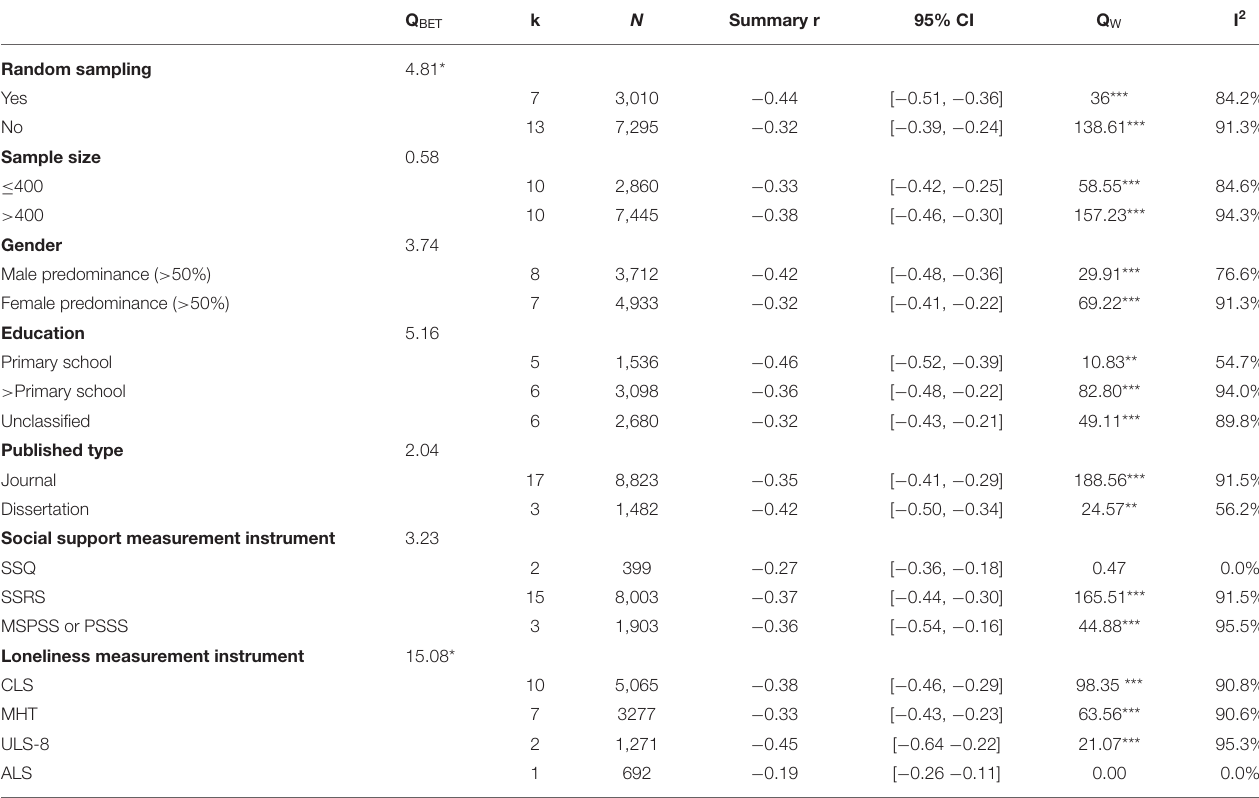
TABLE 2 | Subgroup analyses of the summary correlation between social support and loneliness among LBC. Q BET k N Summary r 95% CI Q